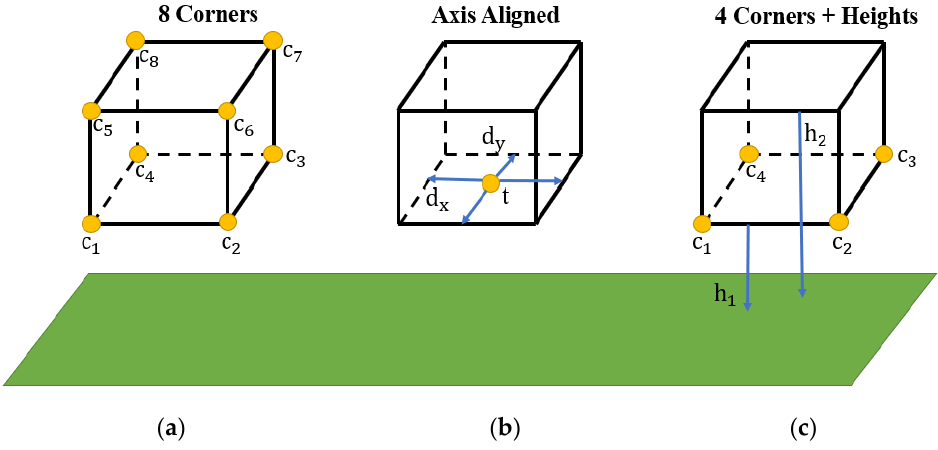
Figure 7. 3D bounding box encoding method. ( a ) 8 corner box encoding. ( b ) Axis aligned box encoding. ( c ) 4 corner encoding.